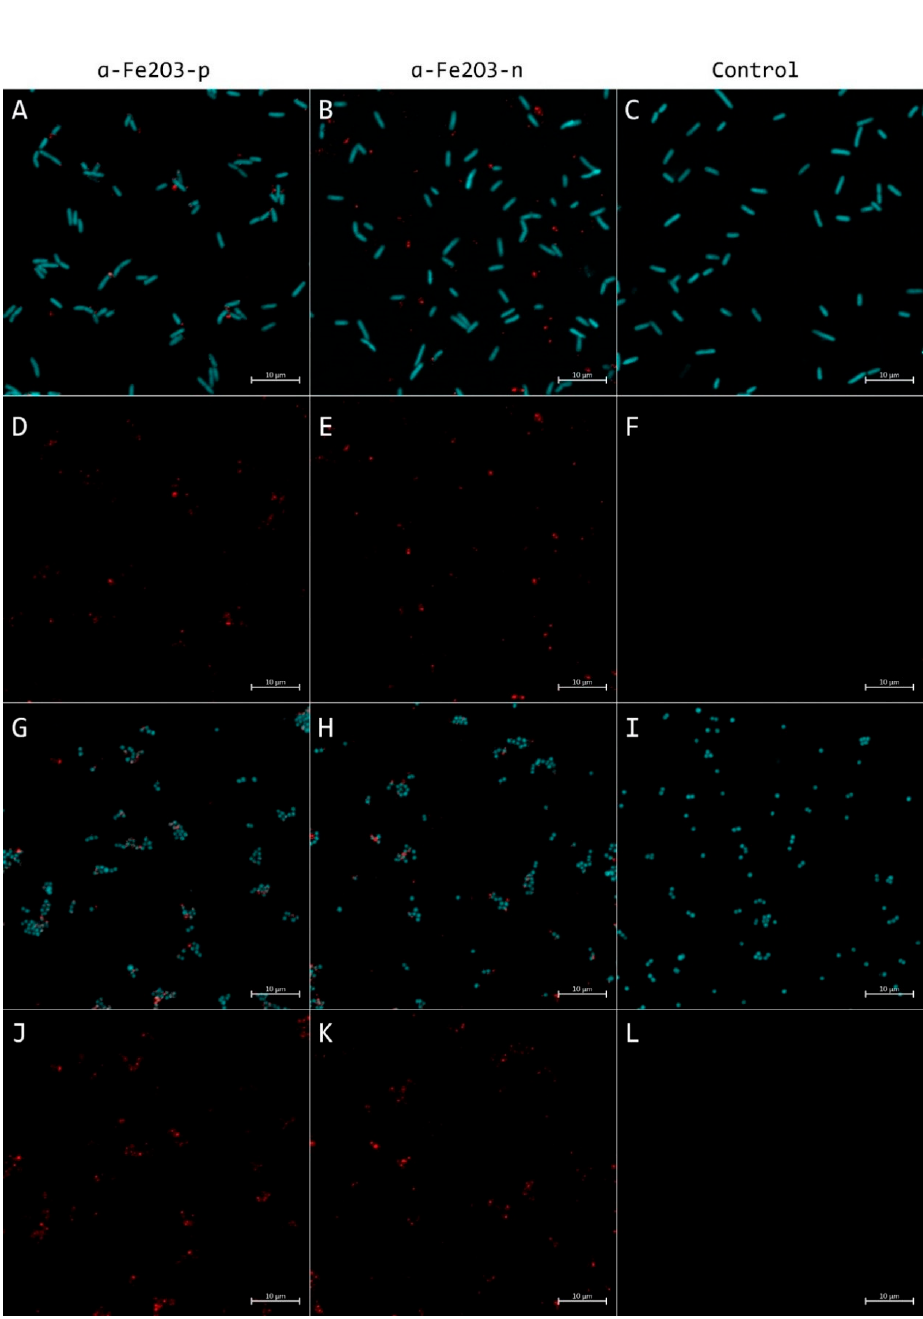
Figure 11. Representative maximal projections of confocal laser scanning microscopy (CLSM)